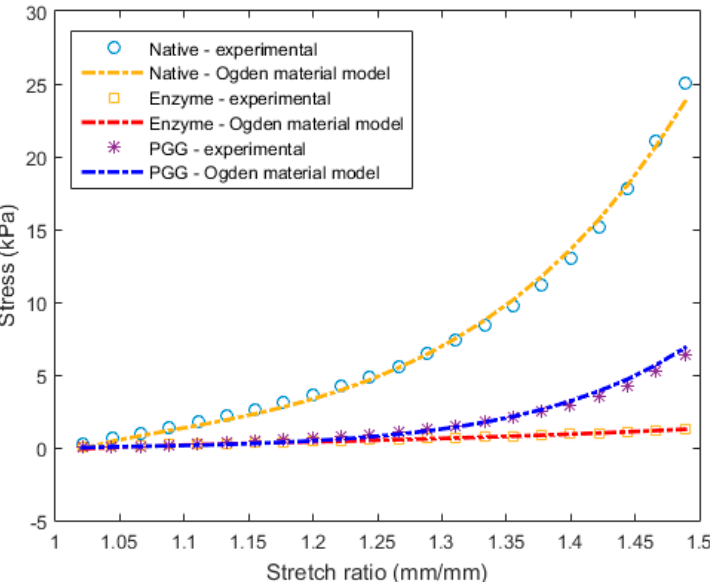
Figure 6. Ogden model fitting with the corresponding experimental stress–strain curves for an exemplary specimen of the native (N), enzyme (E), and PGG treatment (P) groups. Table 2. Ogden material model constants (mean ± SEM) for the three tissue types.